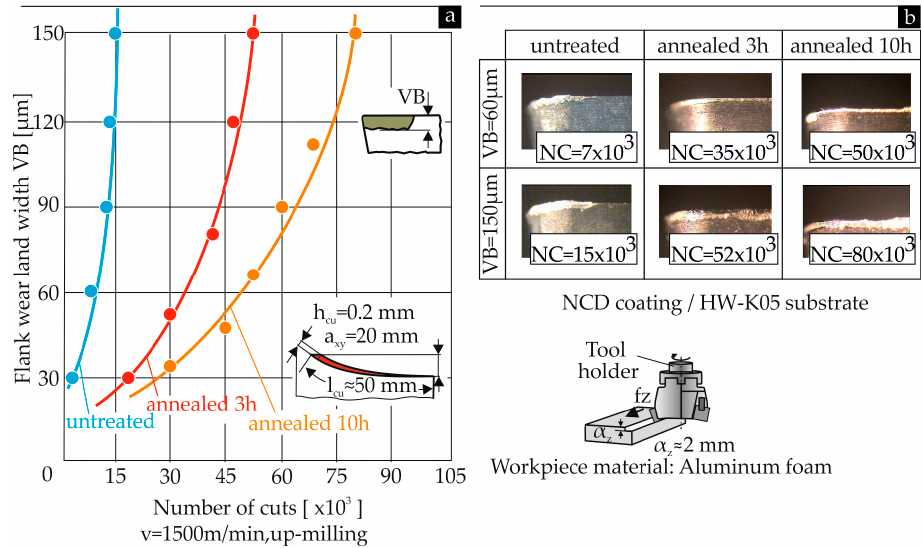
Figure 12. ( a ) Flank wear development versus the number of cuts of the investigated diamond coated inserts; ( b ) characteristic micro-graphs of the worn cutting edges in the examined coated inserts.